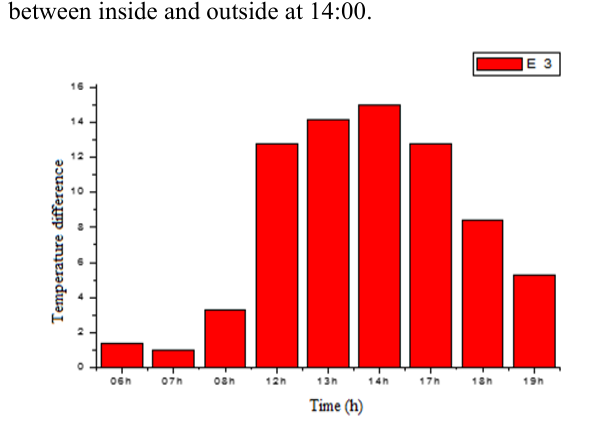
Figure 13. Variations of the internal and external temperatures in terms of the hours of the day.